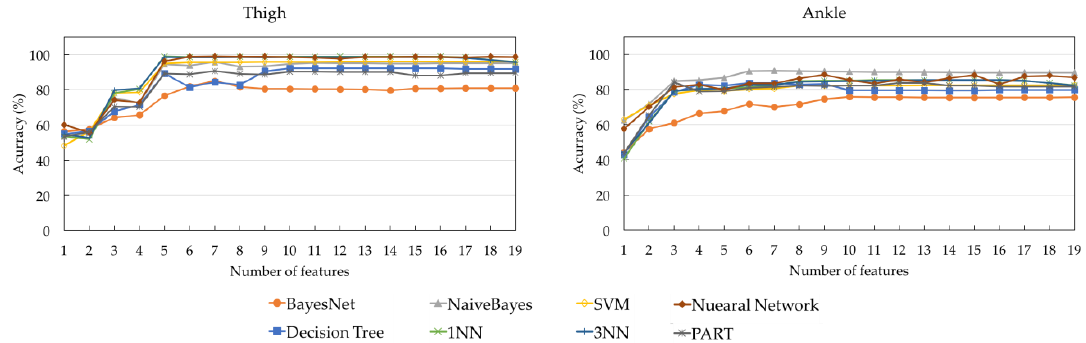
Figure 7. Accuracy of different classification algorithms across all sensor positions. Table 3. Settings with the highest accuracy for different sensor positions.